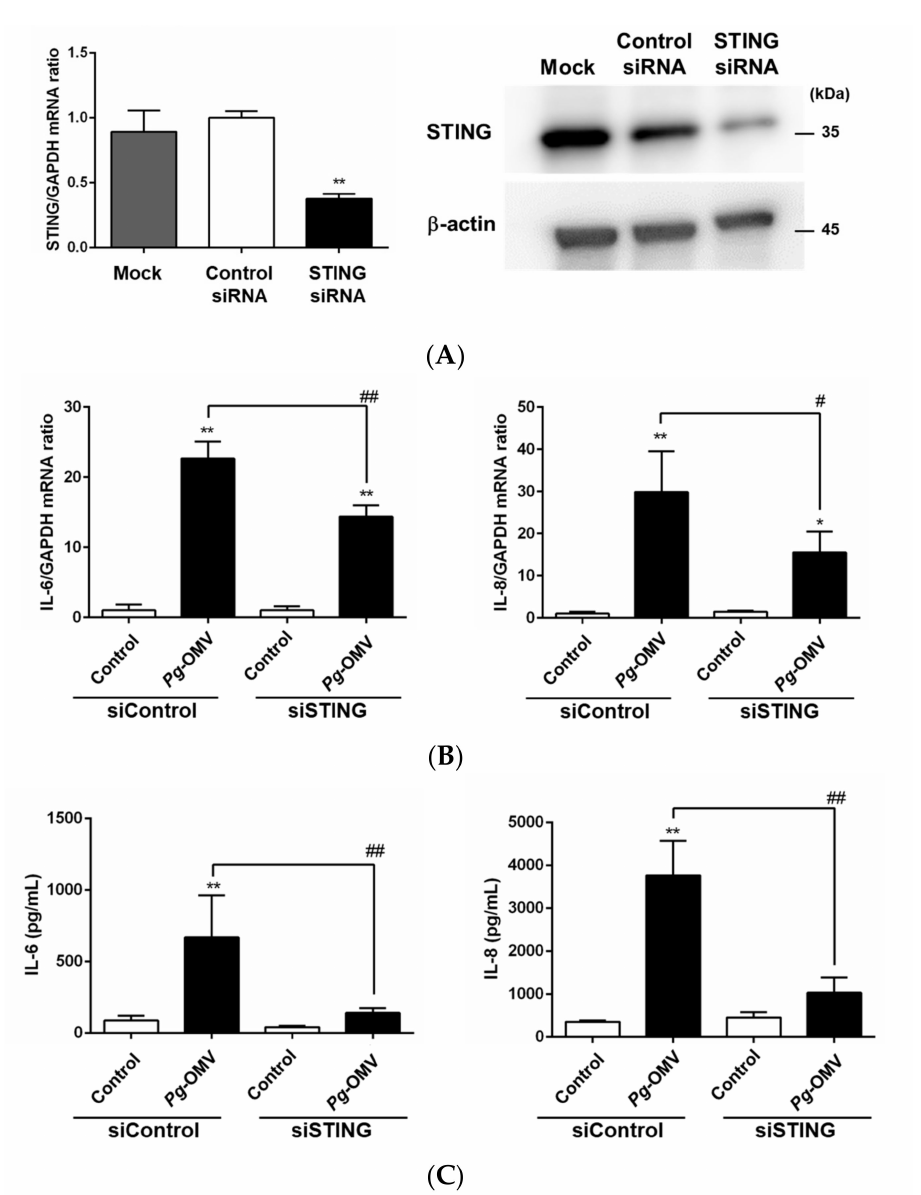
Figure 5. The effect of STING knockdown on the mRNA expression and protein levels of IL-6 and IL-8 in OBA-9 cells. OBA-9 cells were transfected with STING siRNA for 24 h ( A ); and cultured with Pg -OMVs for 3 h ( B ); and then 6 h ( C ). The amount of Pg -OMVs added to cells was determined by using the same level of endotoxin activity as 100 ng/mL of Pg -LPS. ( A , left ) STING mRNA was analyzed using qRT-PCR. ( A , right ) STING protein levels were determined by Western blotting; representative blots are shown. ( B ) IL-6 and IL-8 mRNA expression levels were analyzed using qRT-PCR. ( C ) IL-6 and IL-8 concentrations in the cell culture supernatants were determined using an ELISA program. Data are the mean ± SD of three independent experiments. * p < 0.05 and ** p < 0.01, compared to the unstimulated control. # p < 0.05 and ## p < 0.01, compared to the negative control